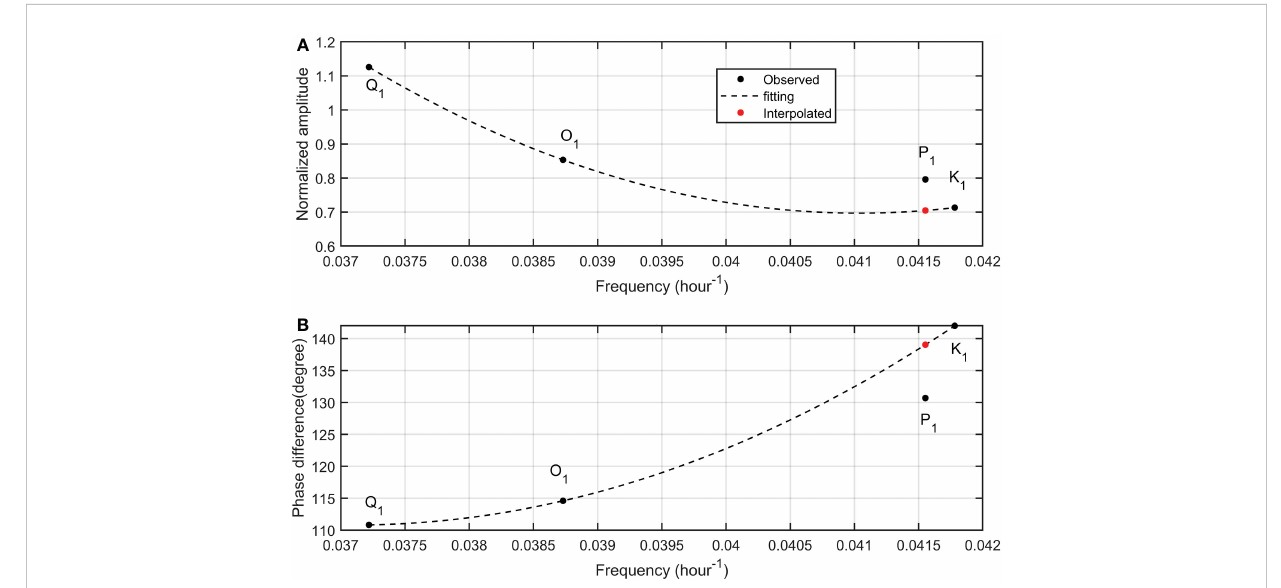
FIGURE 4 Normalized tidal amplitudes (A) and phase differences (B) for main diurnal tides at depth of 1800m from the mooring. Black dots are observed tidal admittances while red dots are interpolated admittances. Dash lines are determined via ordinary least